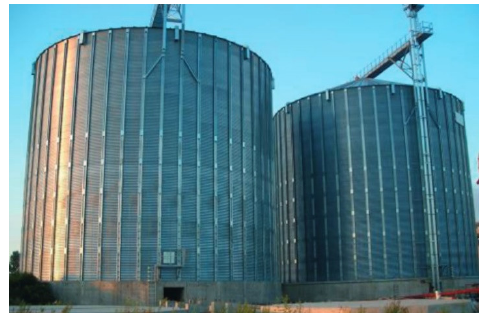
Figure 5. Silo corrugated walls in combination with the vertical stiffeners (well-known as silo col- umns). Source: